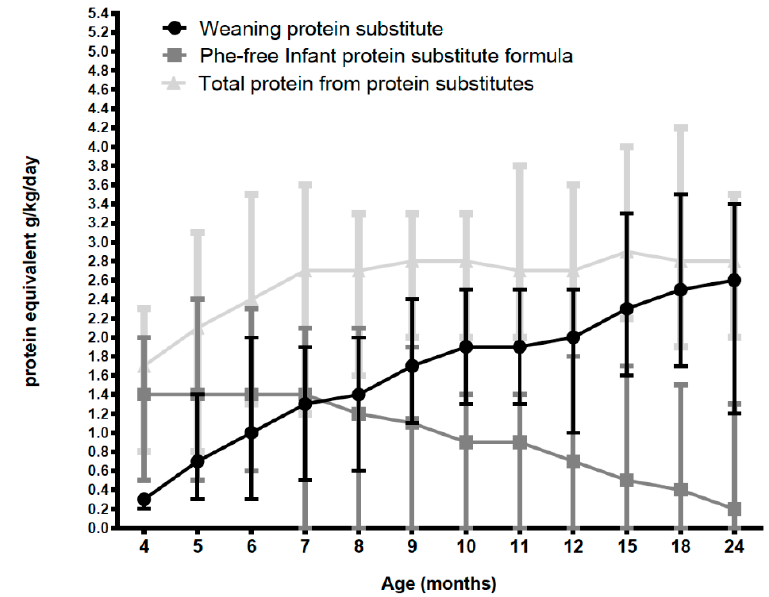
Figure 5. Mean protein intake g/kg/day from total protein substitute, weaning protein substitute, and Phe-free infant formula.